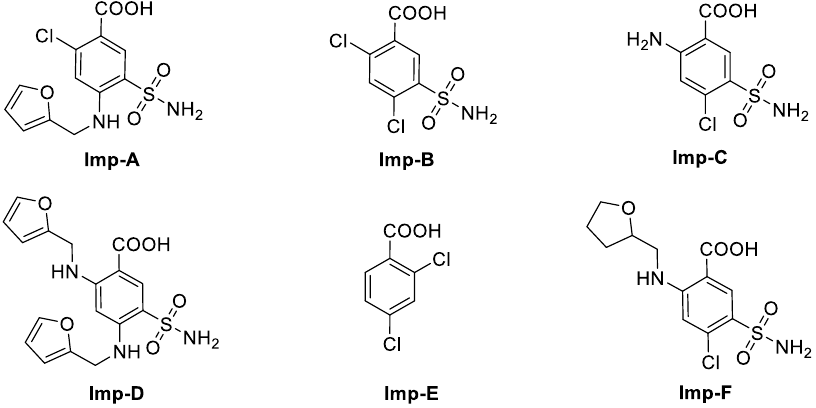
Figure 2. Chemical structures of impurities A – F registered in EP 10.0.